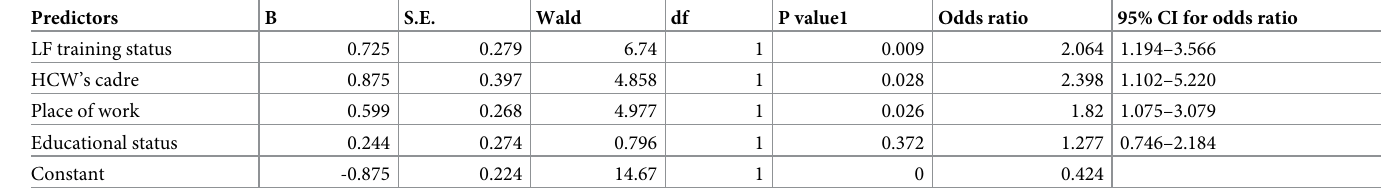
Table 6. Predictors of knowledge of Lassa fever and its prevention and control measures among healthcare workers during an outbreak in Katsina, Nigeria (N = 400). Predictors